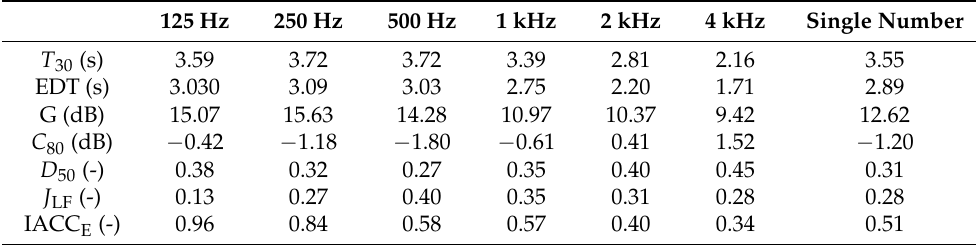
Table 4. Acoustic parameter values in frequency octave band and single number frequency averaging